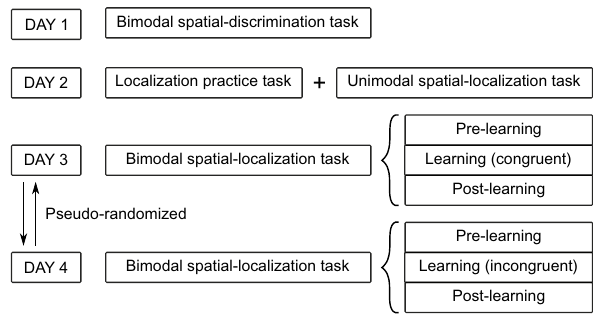
Figure 1. Task order across